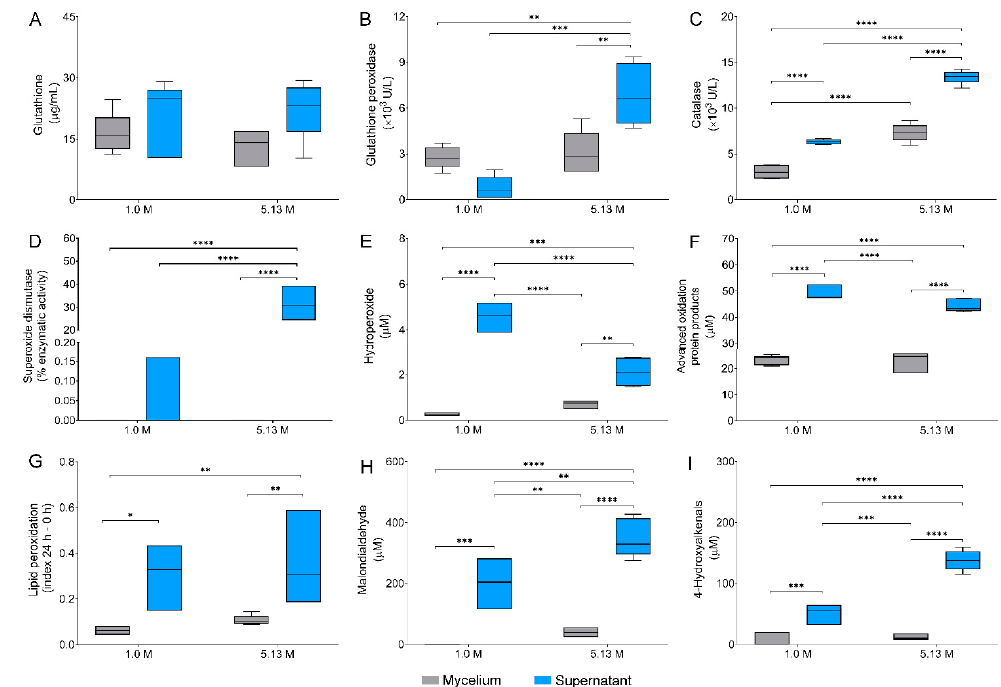
Figure 4. Oxidative stress responses in Aspergillus sydowii EXF-12860. Nine oxidative stress